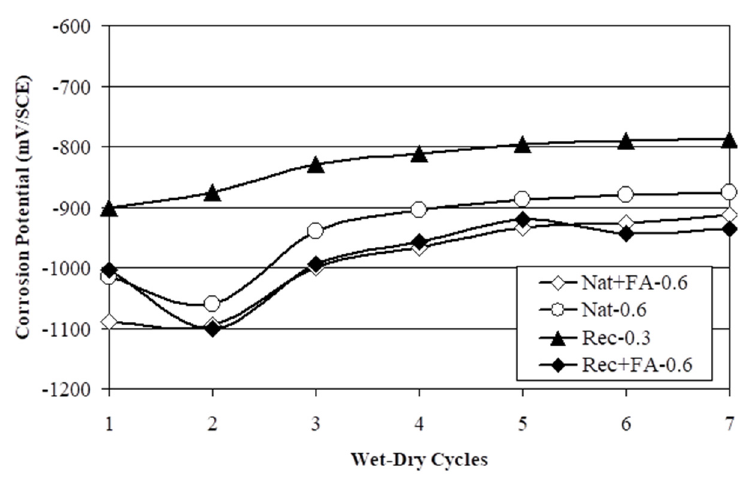
Figure 8. Corrosion potential of galvanized steel plates in cracked concrete vs. wet–dry cycles.